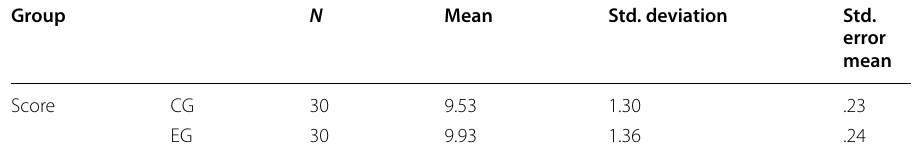
Table 6 Fluency pre‑test descriptive statistics